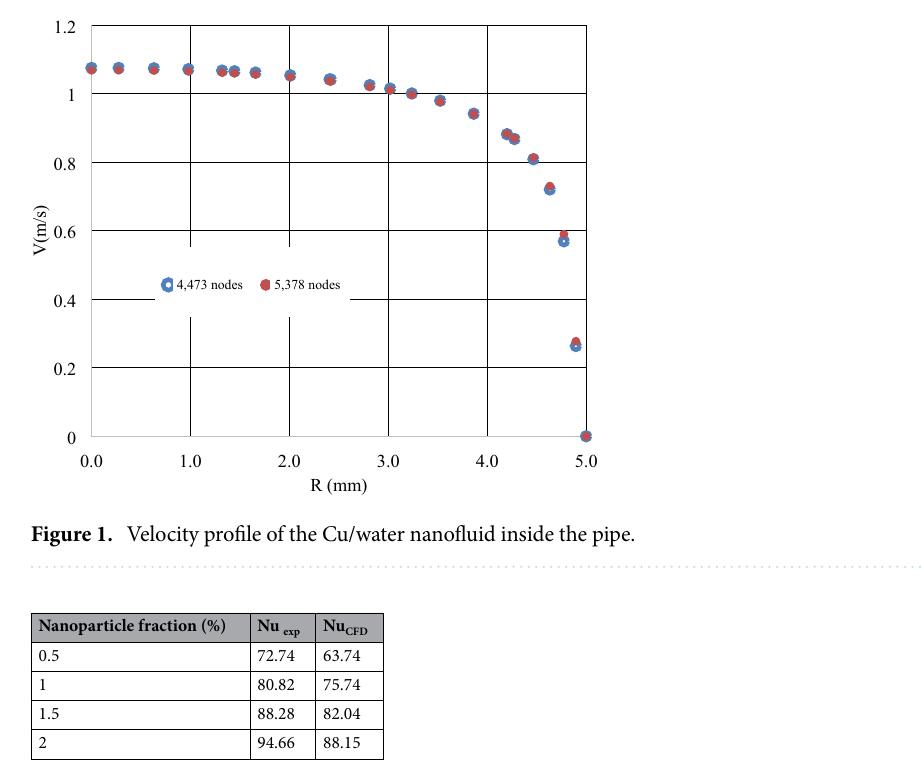
Table 2. Validation test of CFD 32,33